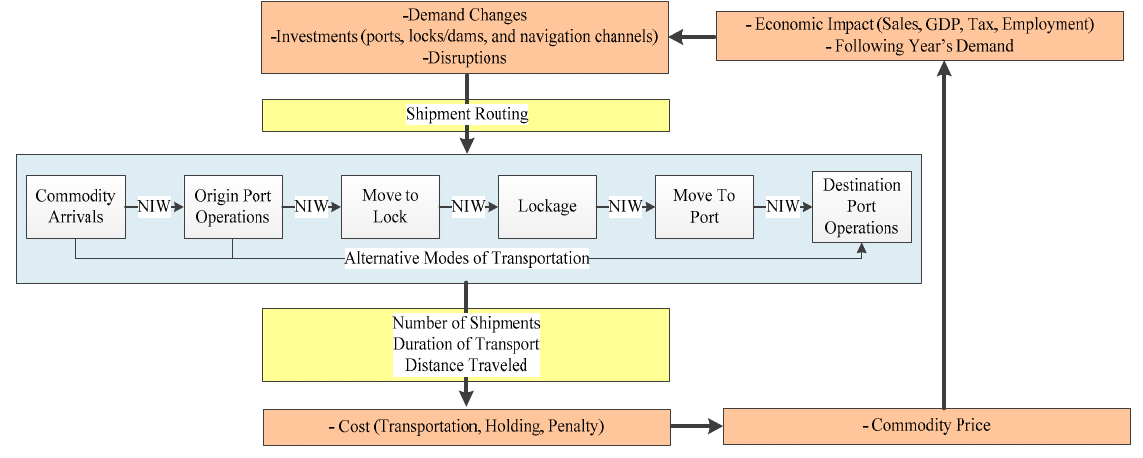
Figure 2. MarTranS process flow